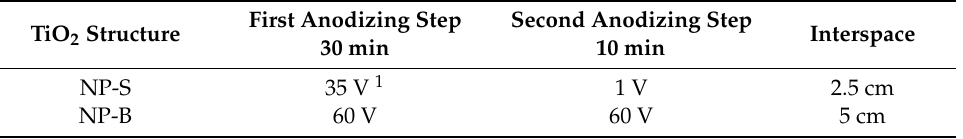
Table 2. Conditions for the two-step anodizing process carried out. Voltage conditions applied and the interspace between the electrodes used during